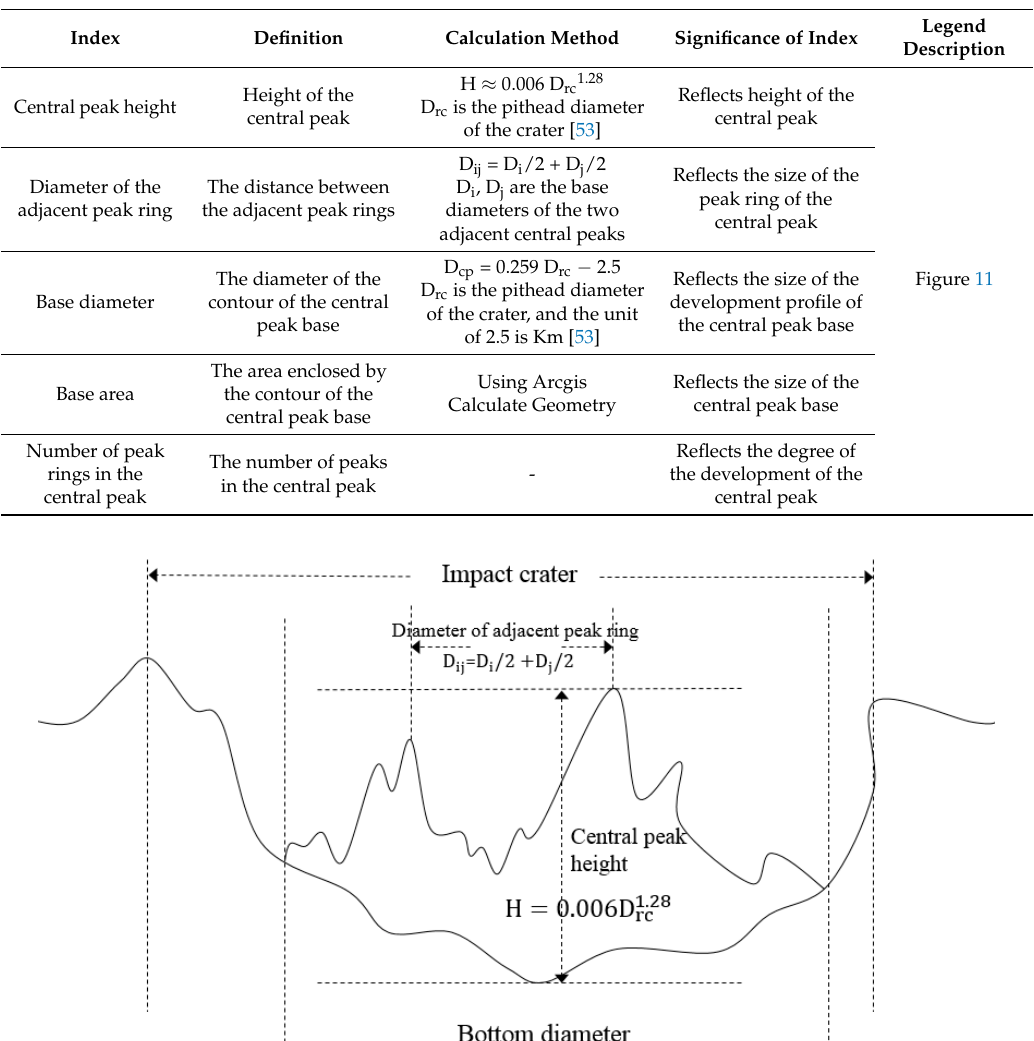
Table 5. Indices for description of the central peaks.